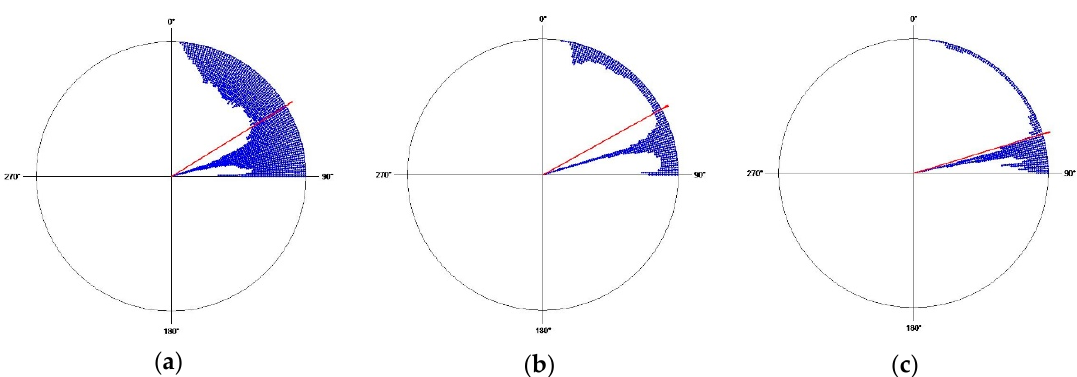
Figure 5. Raw slope data in ( a ) zone 1, ( b ) zone 2, and ( c ) zone 3. The mean azimuth is plotted in red.